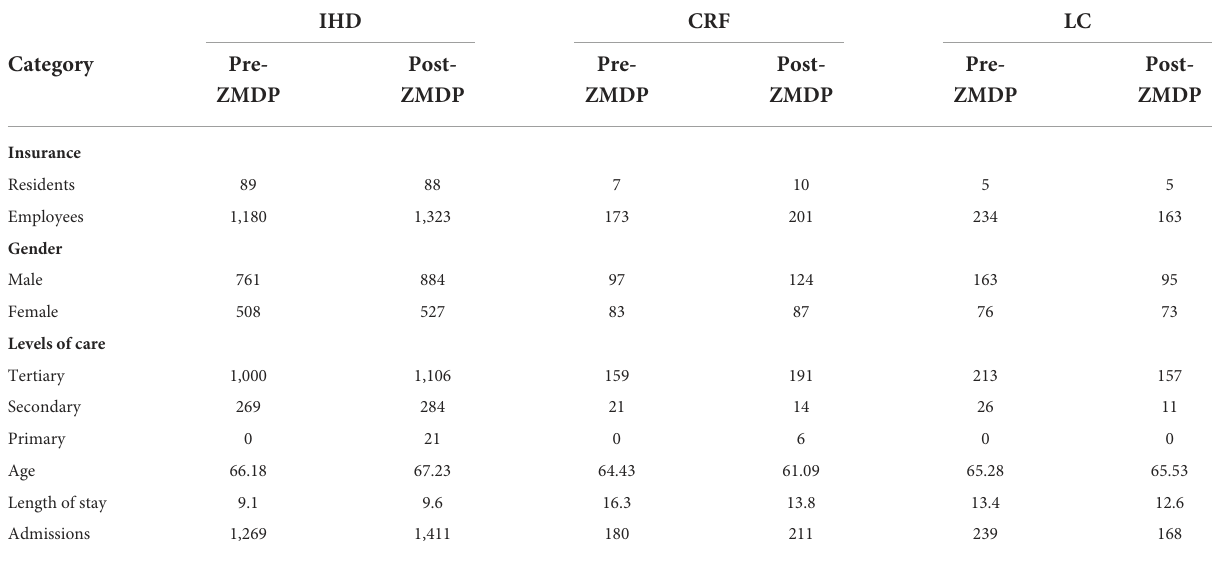
TABLE 1 Basic characteristics of inpatients.